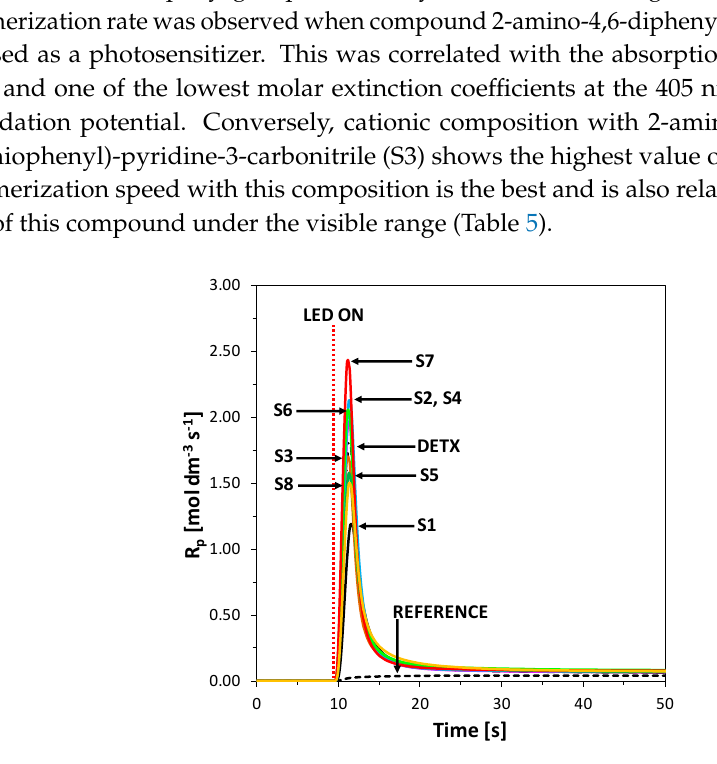
Figure 15. Polymerization rate profiles for photopolymerization of TMPTA with HIP (1 wt.%) and 2-amino-4,6-diphenyl-pyridine-3-carbonitrile derivatives (0.1 wt.%) under MPM lamp with 400–500 nm filter (intensity at the surface of sample 75 mW / cm 2 ) irradiation, calculated from photo-DSC data. The irradiation starts at t = 10